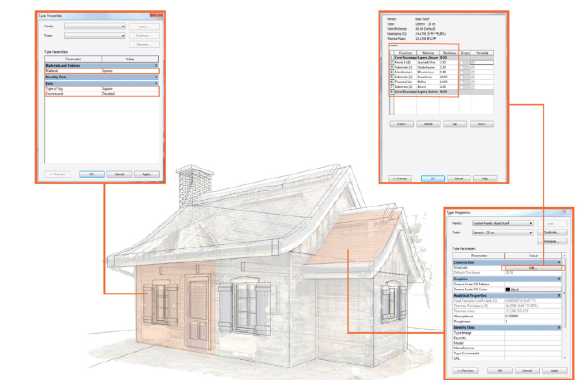
Figure 18. HBIM of Clagett log cabin